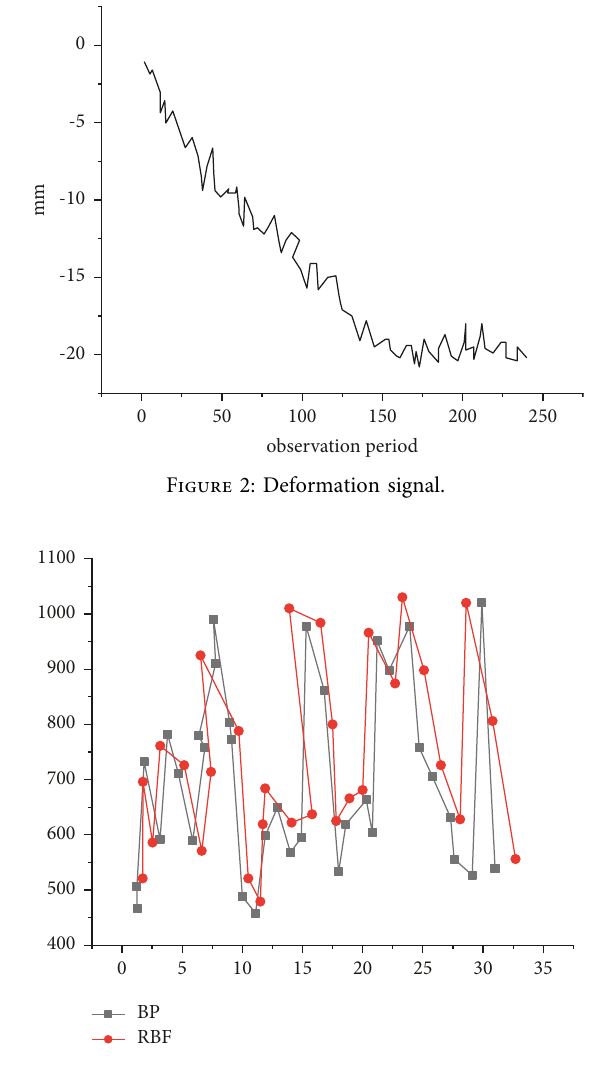
Figure 3: BP network prediction and RBF network